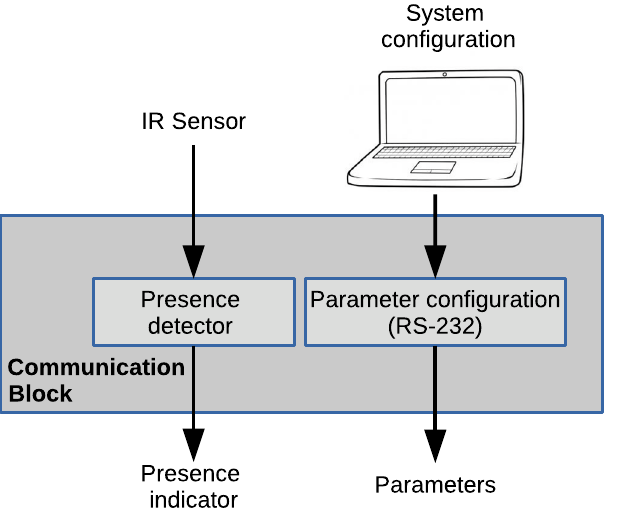
Figure 4. Block diagram of the communication module.